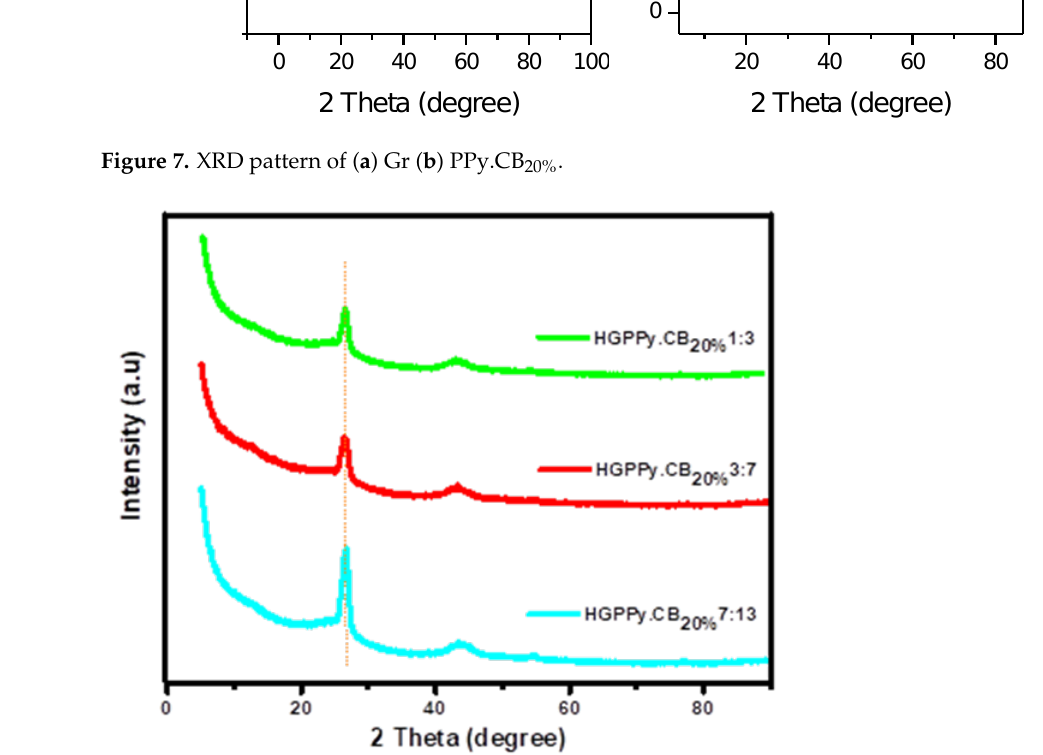
Figure 8. Comparison of the HGPPy.CB 20% structures.